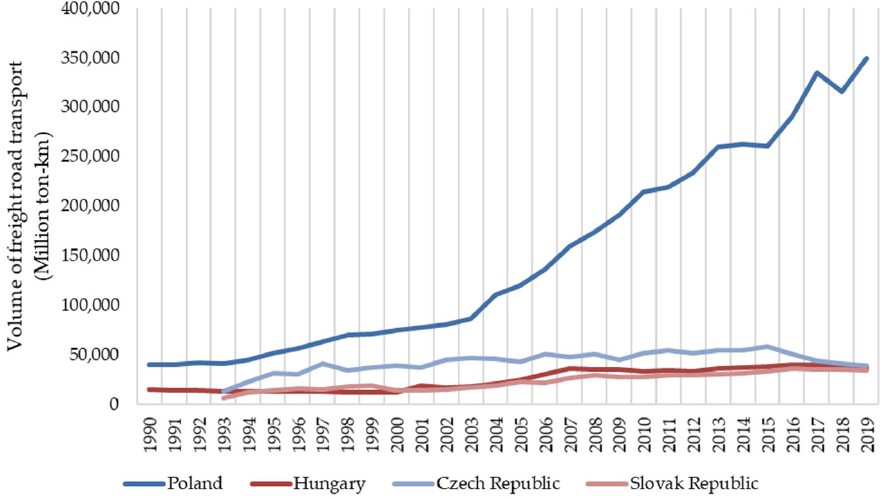
Figure 4. Freight transport by road in V4 countries in 1990–2019 (in million tonnes-kilometres). Source: OECD database.